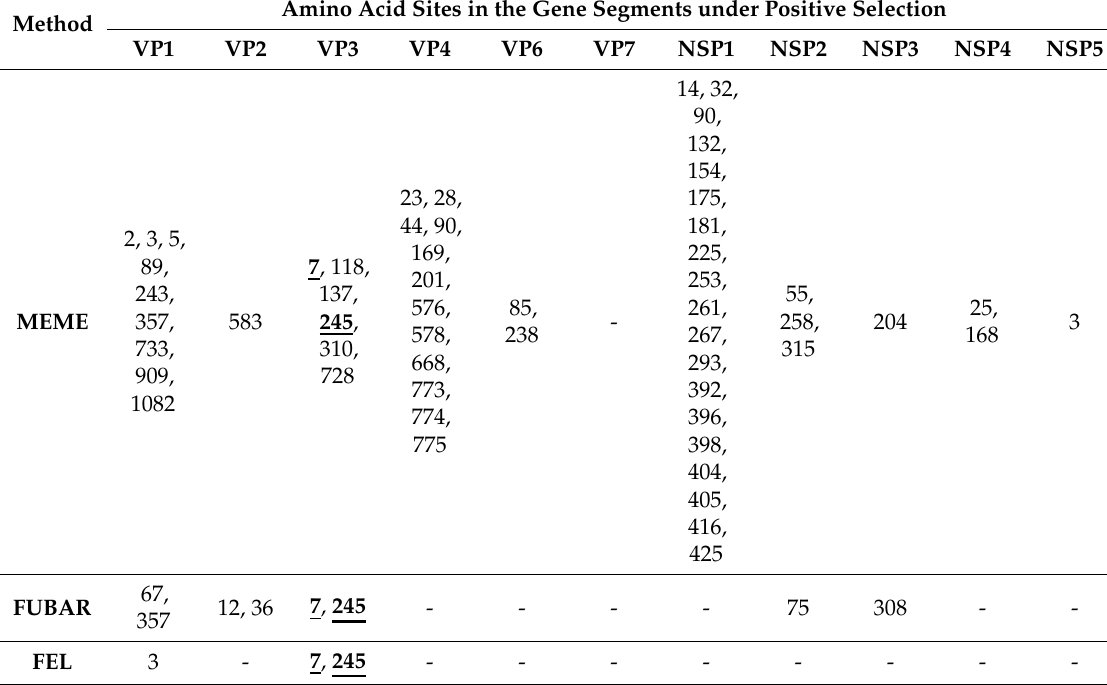
Table 4. Positively selected sites as identified by FEL, FUBAR, and MEME